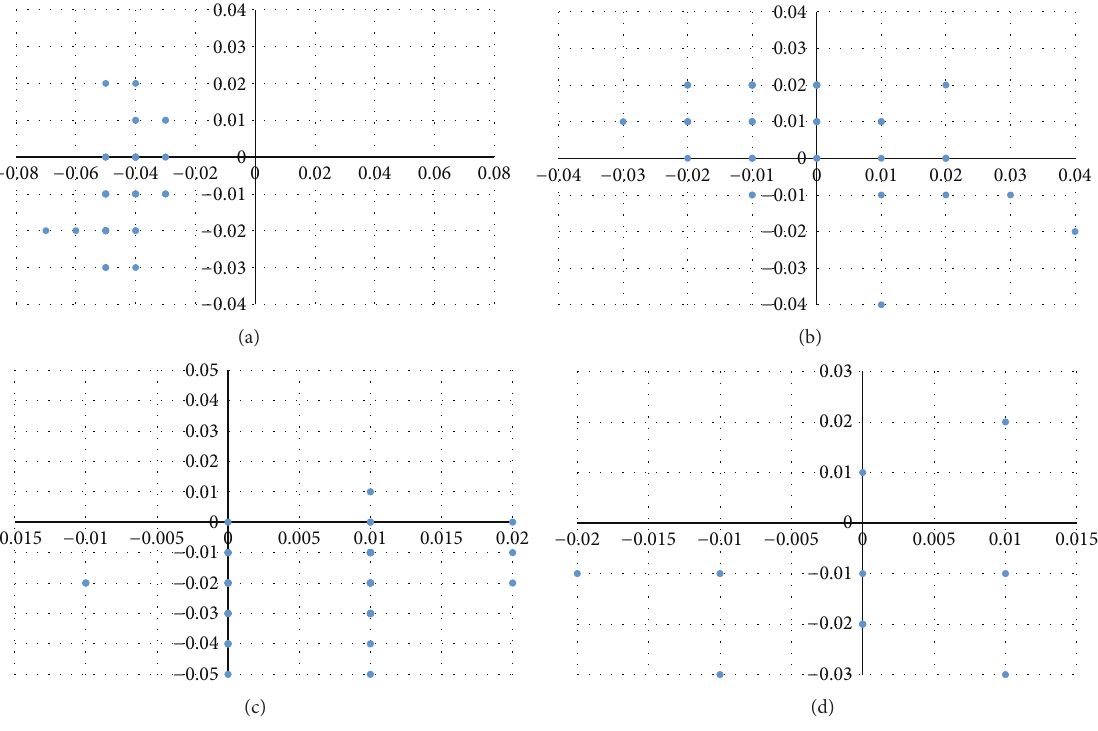
Figure 14: Robot movement position error. (a) Grasping position error. (b) Placing position error. (c) Charge station position error. (d) Entry button position error.